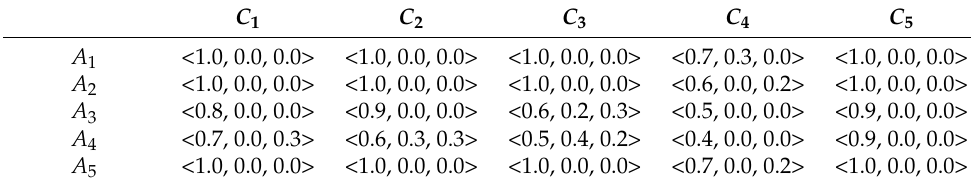
Table 18. The group decision-making matrix.